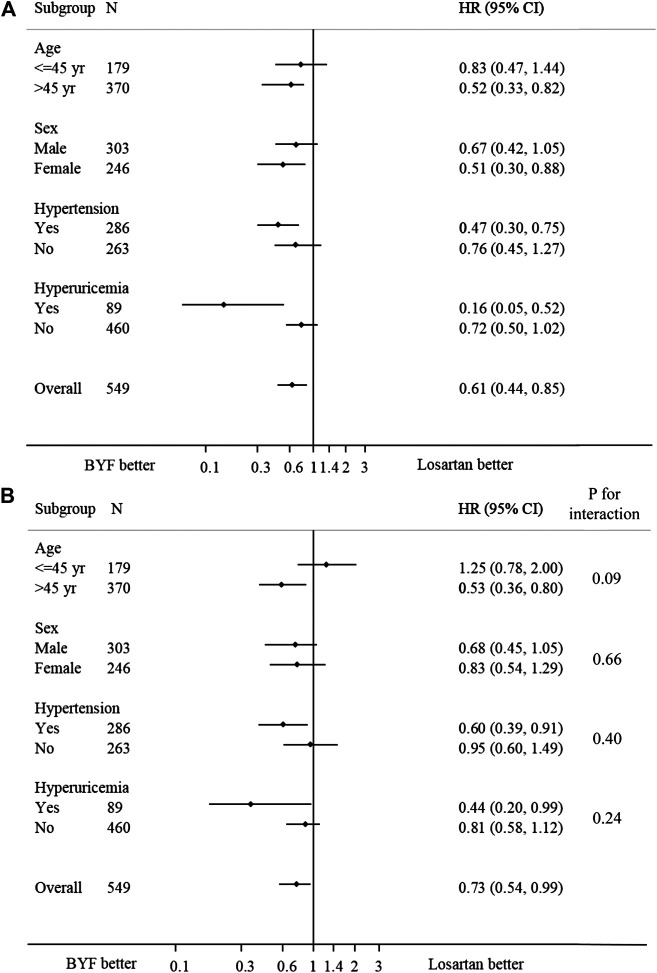
Forest plot of the effect of Bupi Yishen Formula (BYF) on the composite endpoint by subgroups. (A) Model 1: no adjustment. (B) Model 2: adjusted for center effect, sex, age, change of weight over 48 weeks, baseline estimated glomerular filtration rate (eGFR), and morbidities (hypertension, gout, or hyperuricemia).